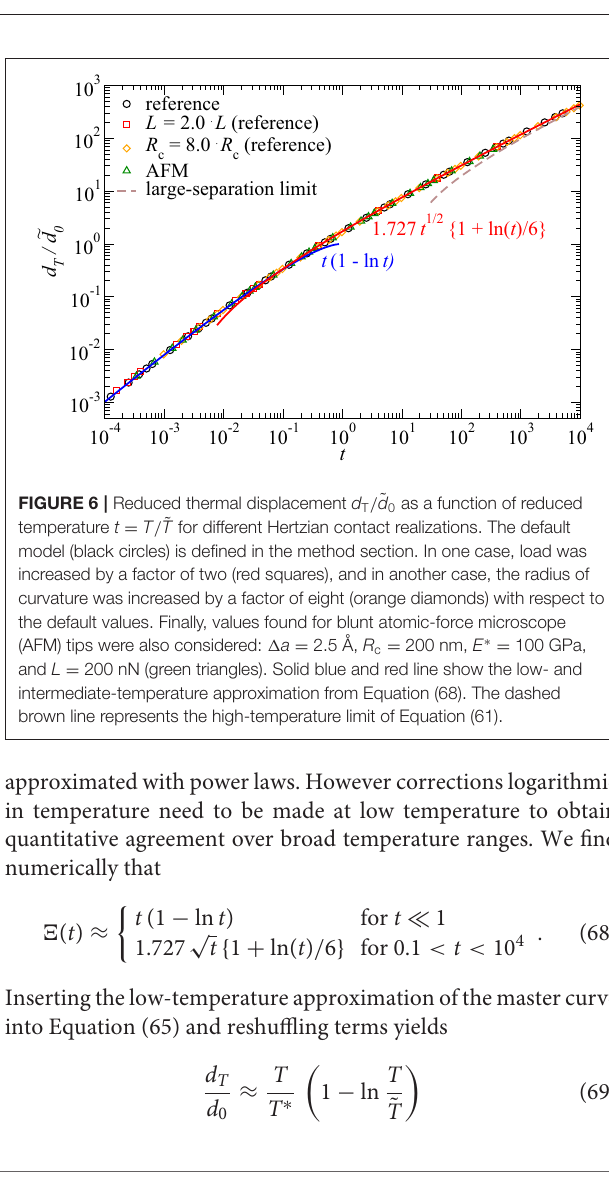
FIGURE 5 | (Left) Interfacial stress σ as a function of distance r from the symmetry axis in a Hertzian contact geometry. The (blue) circles reflect zero temperature data from the hard-wall overlap potential. The full (blue) line represents the analytical solution to the Hertz problem. The (red) open squares show finite-temperature data from full simulations, while the (red) dotted line shows zero-temperature simulations, in which, however, the effective potential was constructed to reflect thermal vibrations at the given temperature. The arrow marks the point of largest slope for the thermal indenter. (Right) Displacement field u ( r ) as a function of distance r from the symmetry axis.